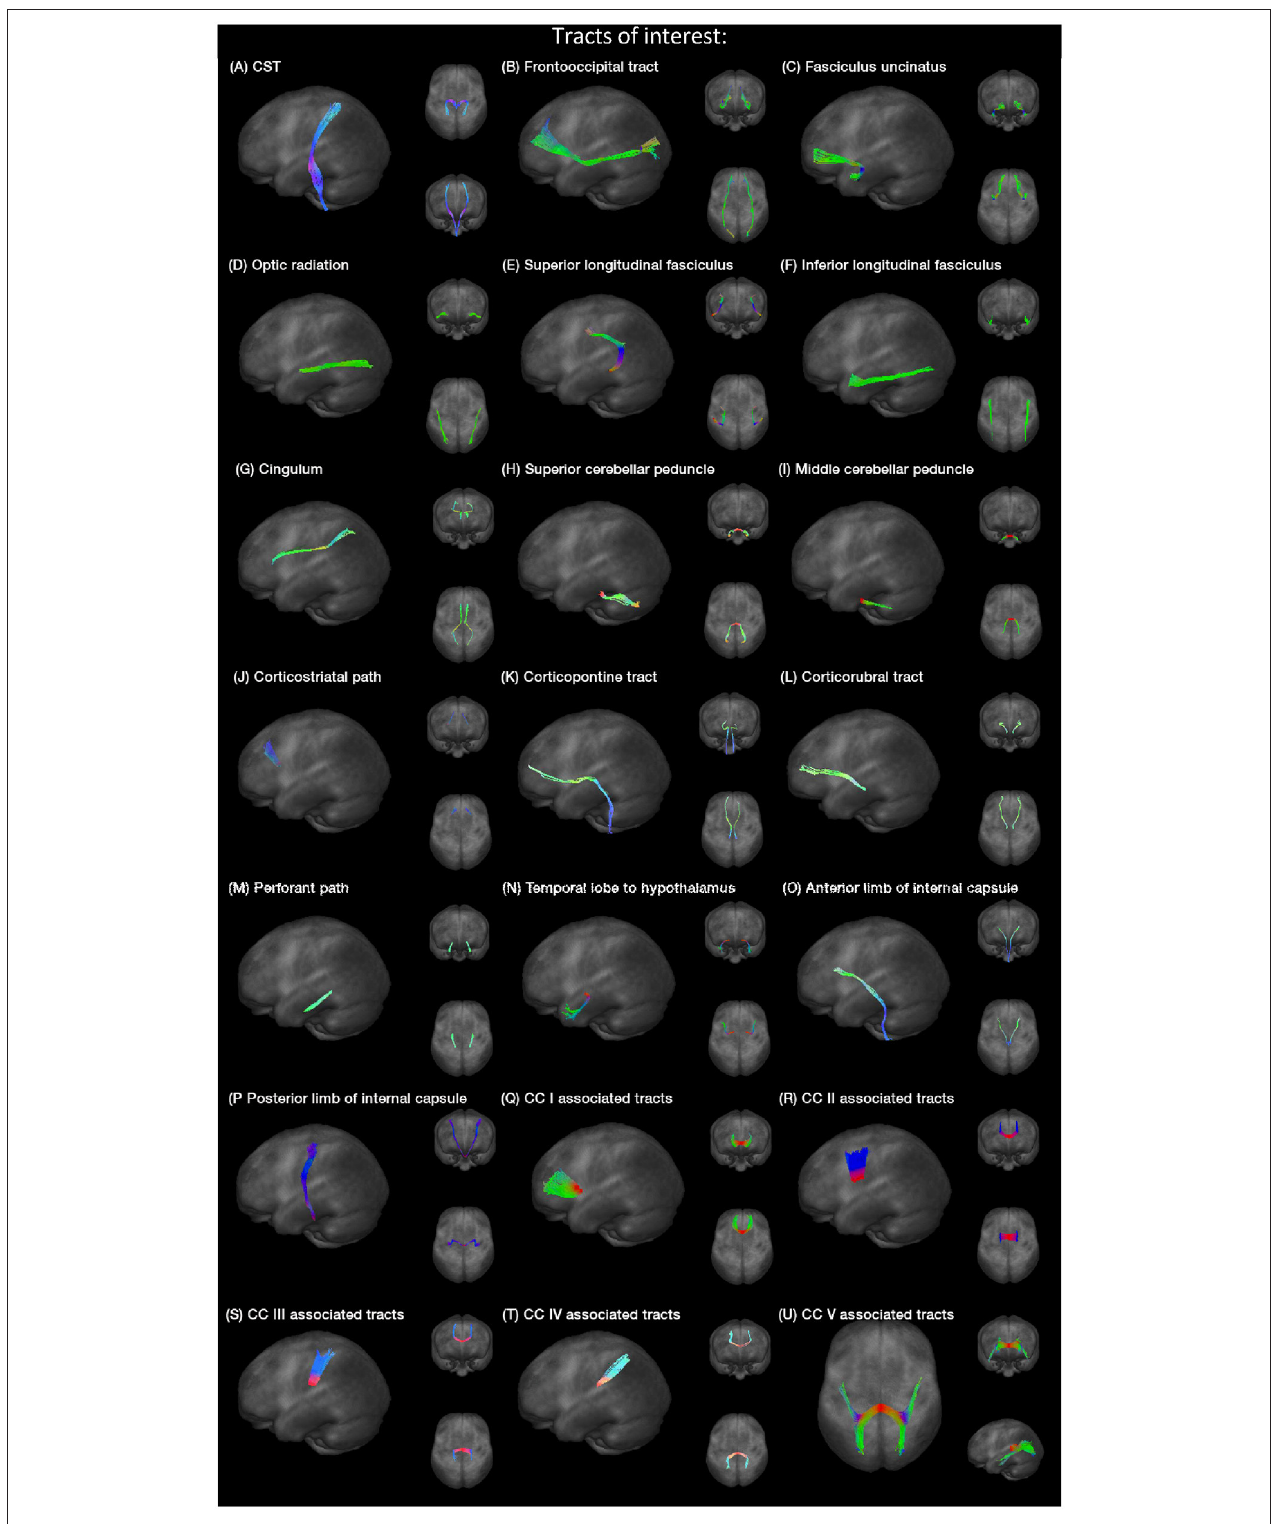
FIGURE 2 | (A–U) Projectional views of TOIs (CC, corpus callosum).